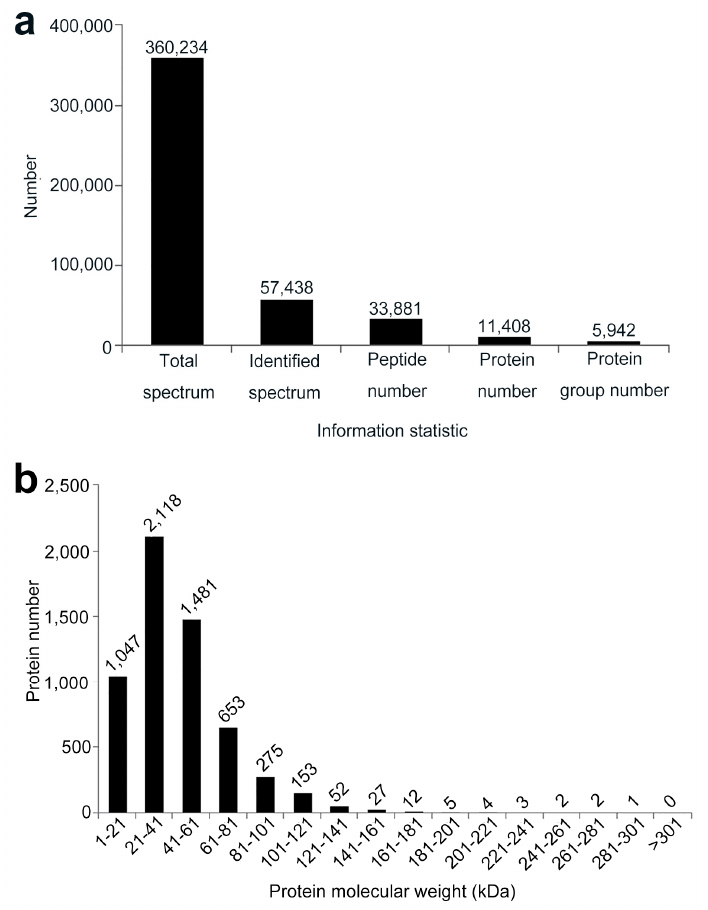
Figure 2. ( a ) Basic protein information statistic for the Isobaric Tags for Relative and Absolute Quantitation (iTRAQ) analysis. ( b ) Distribution of protein molecular weight from the iTRAQ analysis.